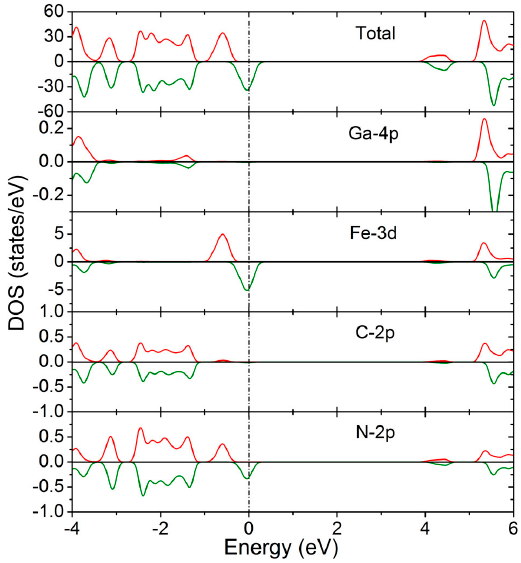
Figure 6. Total and local density of states of GaFe(CN) 6 at 0 GPa.